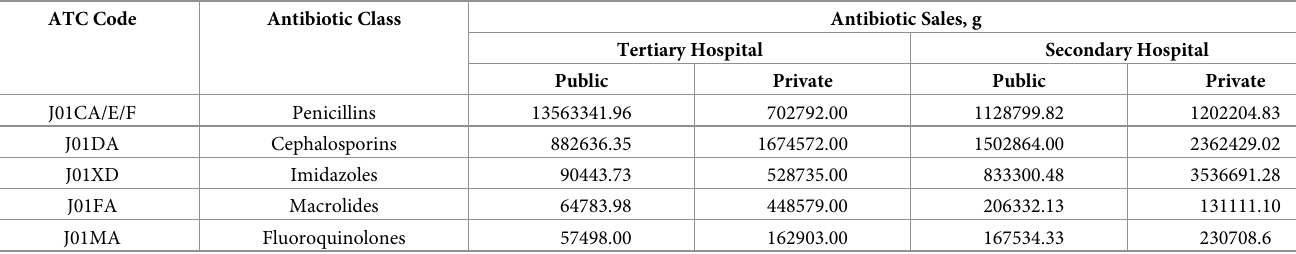
Table 2. Most commonly prescribed antibiotic classes in hospitals.